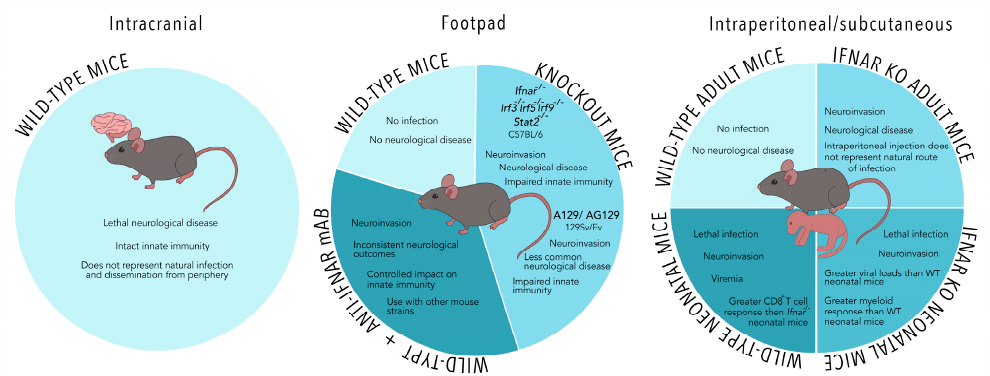
Figure 1. A comparison of models of mosquito-borne Zika virus (ZIKV) infection in non-pregnant mice. IFN-deficient mouse models and the use of anti-IFNAR (type I interferon receptor) monoclonal antibodies are commonly employed to investigate ZIKV infection using subcutaneous, intraperitoneal, or footpad injections as depicted. Footpad infections may be a more representative route to mimic mosquito-borne infection. Intracranial and neonatal models of ZIKV infection bypass the requirement for IFN-deficient transgenic mice but may not represent natural infection of adult